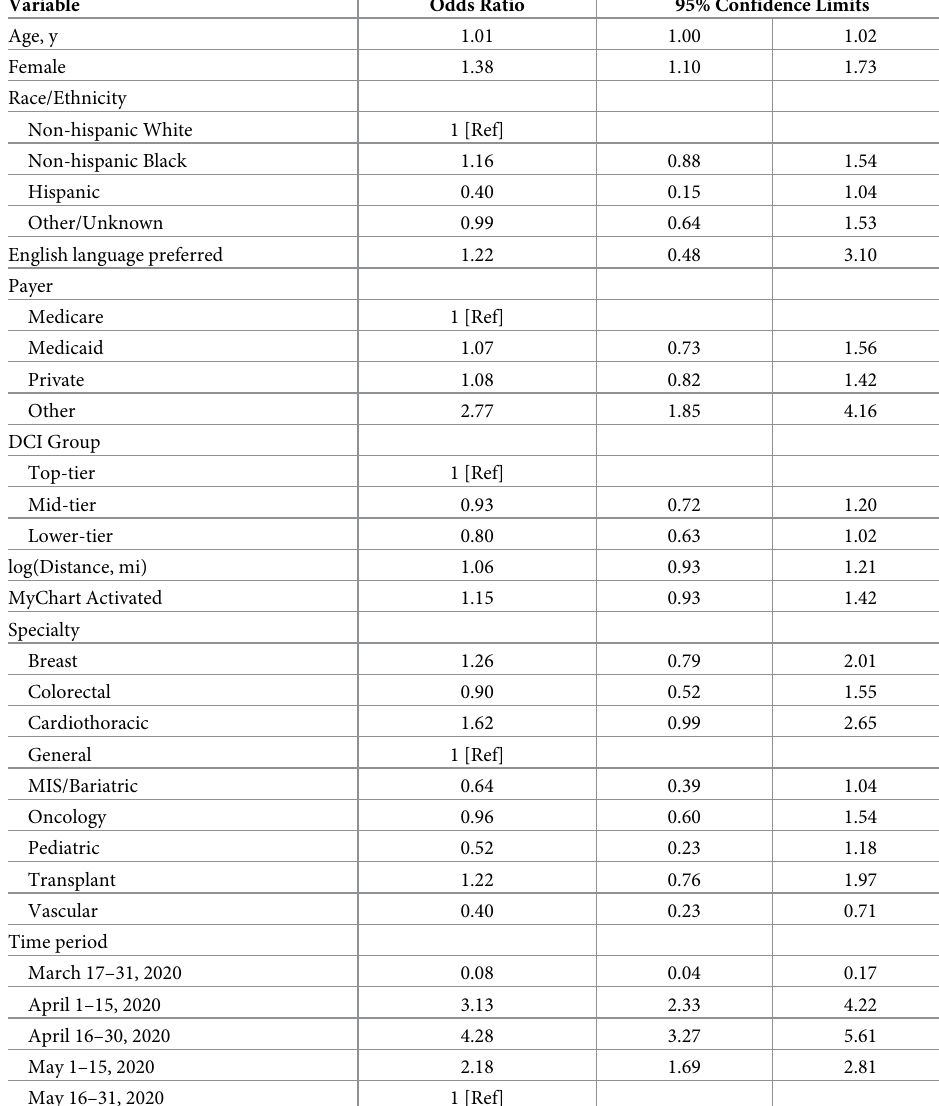
Table 4. Patient characteristics associated with a telemedicine visit during COVID-19, compared to an in-person visit during COVID-19. Variable Odds